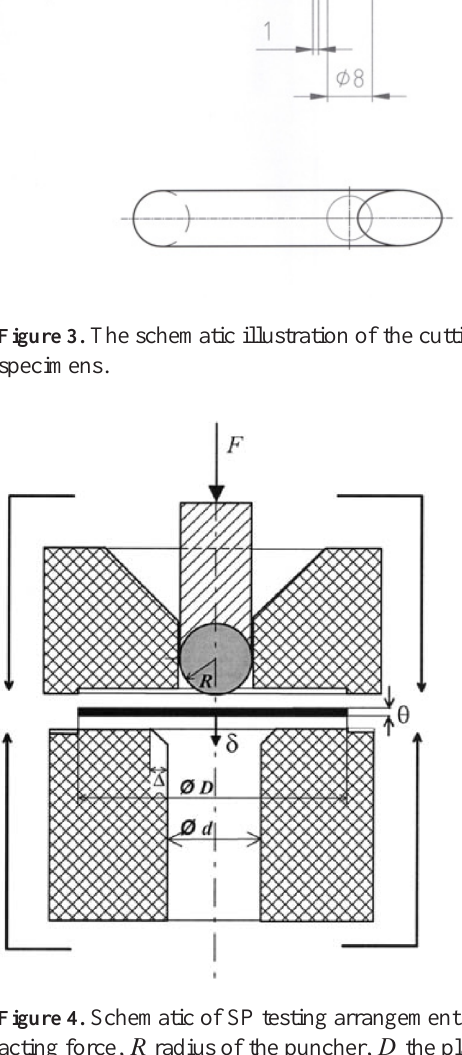
Figure 4. Schematic of SP testing arrangement – F is the acting force, R radius of the puncher, D the planar dimen- sion of the disc specimen with thickness (cid:3) and d diameter of the lower die. The deformation of the disc is character- ized by its central deflection ı